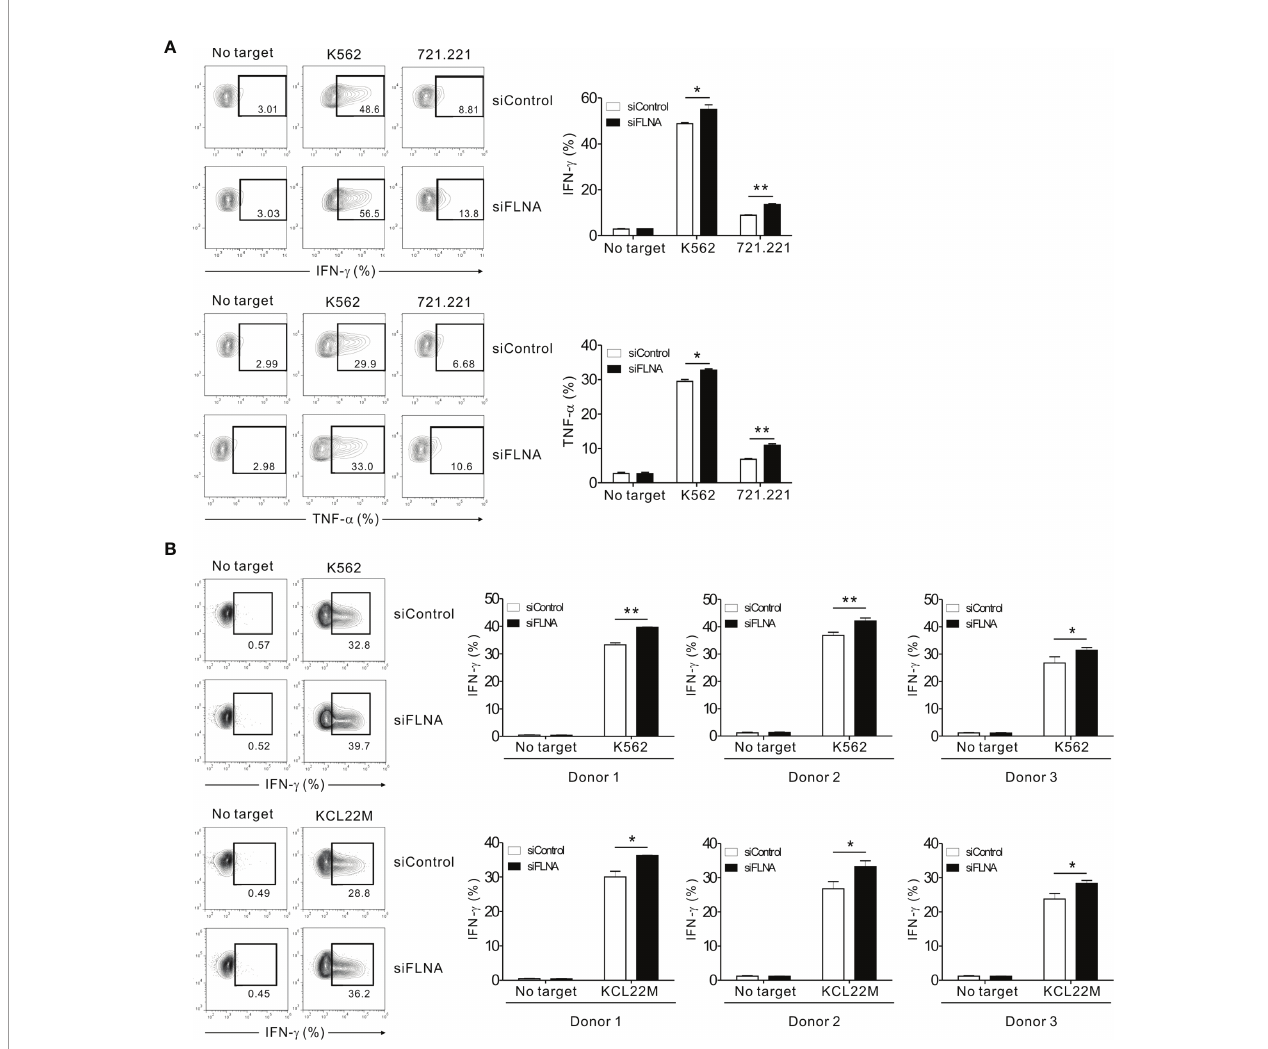
FIGURE 6 | FLNa suppresses cytokine production by NK cells. (A) CD16.NK92 nucleofected with control siRNA or FLNa-speci fi c siRNA were incubated with K562 or 721.221 cells for a total of 6 h to conduct an intracellular cytokine staining assay. Then, the cells were surface stained with labeled anti-CD56 mAbs. NK cell cytokine production was assessed among the CD56+ cells by fl ow cytometry with intracellular staining for IFN- g and TNF- a . Representative FACS pro fi les ( left ) and a summary graph ( right ) showing the expression of IFN- g and TNF- a in CD16.NK92 cells are presented. (B) Primary expanded NK cells nucleofected with control or FLNa-speci fi c siRNAs were incubated with K562 or KCL22M cells for 6 h. Thereafter, the cells were surface stained with a labeled anti-CD56 mAb. NK cell cytokine production was assessed among the CD56+ cells by fl ow cytometry with intracellular staining of IFN- g . Representative FACS pro fi les ( left ) and summary graphs ( right ) showing the expression of IFN- g in primary expanded NK cells from three different healthy donors are presented. Error bars represent the SD; * P < 0.05, ** P < 0.01. Results are representative of three independent